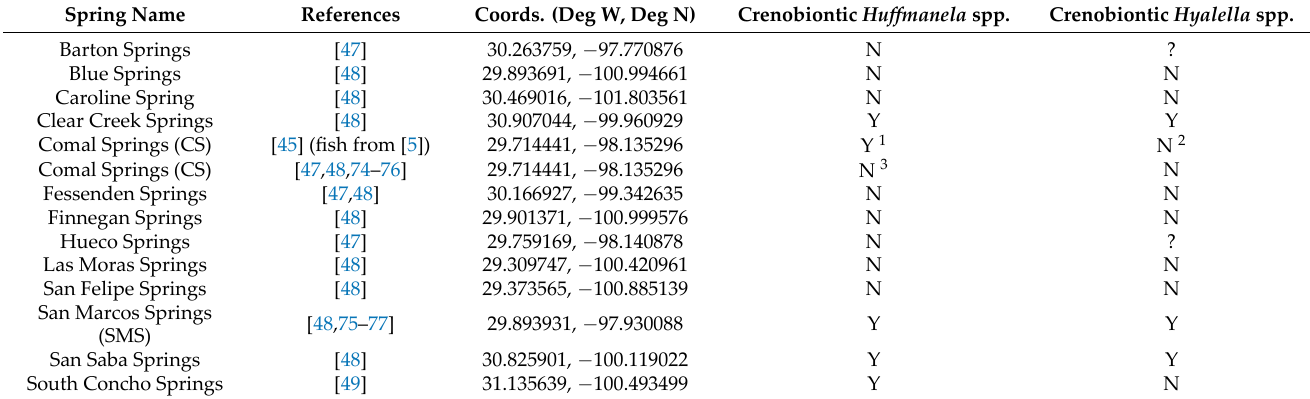
Table 1. Texas springs searched for the presence of mucronate Hyalella spp. or Huffmanela spp. prior to this